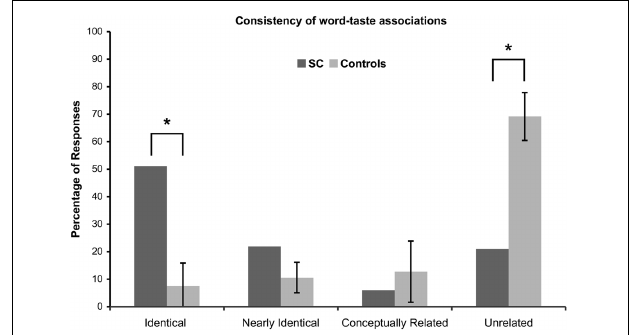
FIGURE 2 | Consistency of word-taste associations. A significant difference is denoted with by ( ∗ ) and corrected for multiple